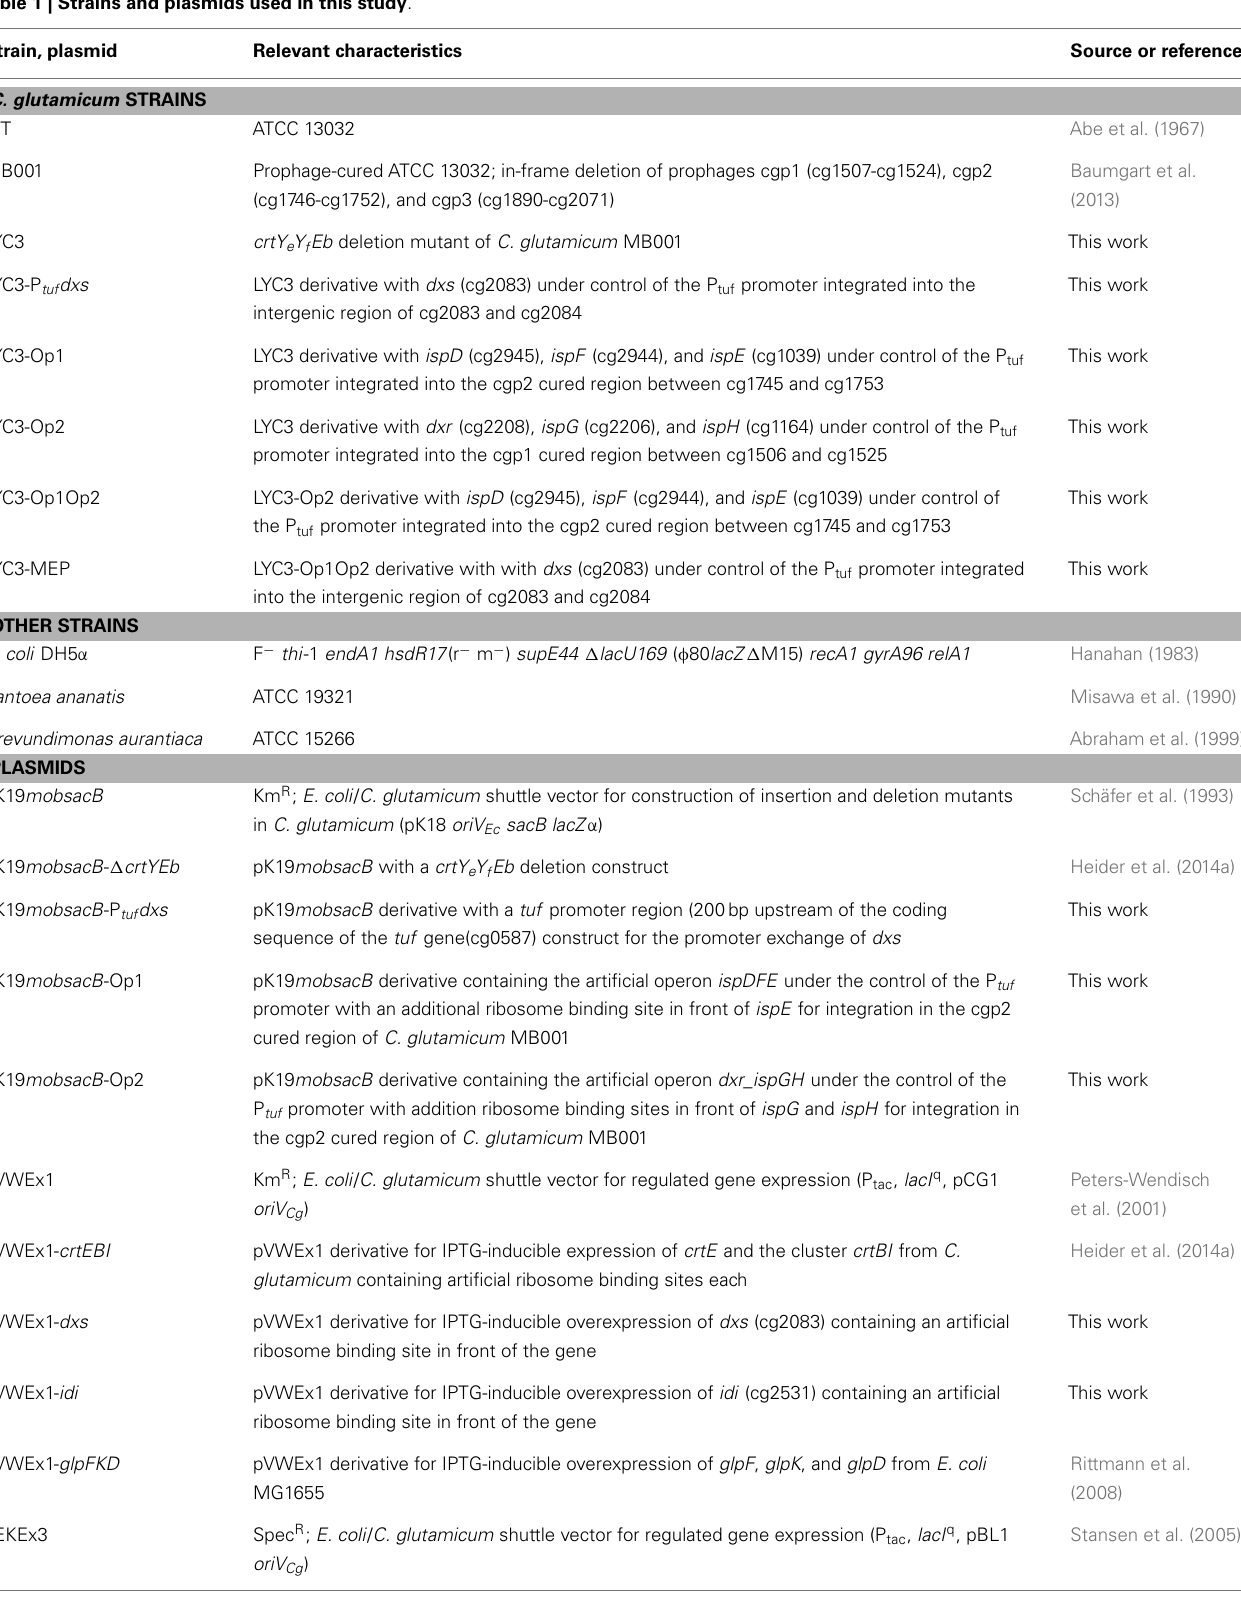
Table 1 | Strains and plasmids used in this study